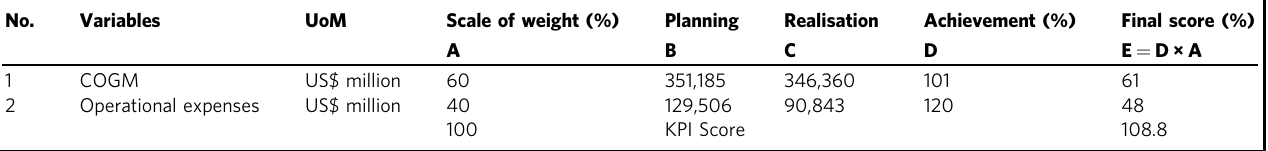
Table 7 Annual bonus formulation for subsidiaries.